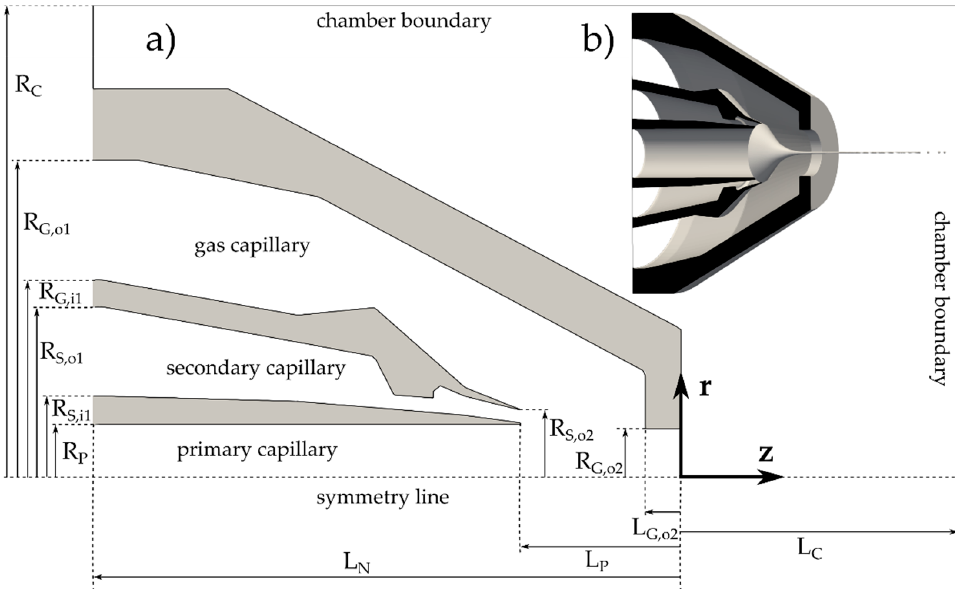
Figure 1. ( a ) A 2D section of a DFFN with relevant dimensions; ( b ) rotated view of a DFFN sliced in half, with a depicted jet leaving the nozzle and breaking it up. The nozzle design is taken from [15].